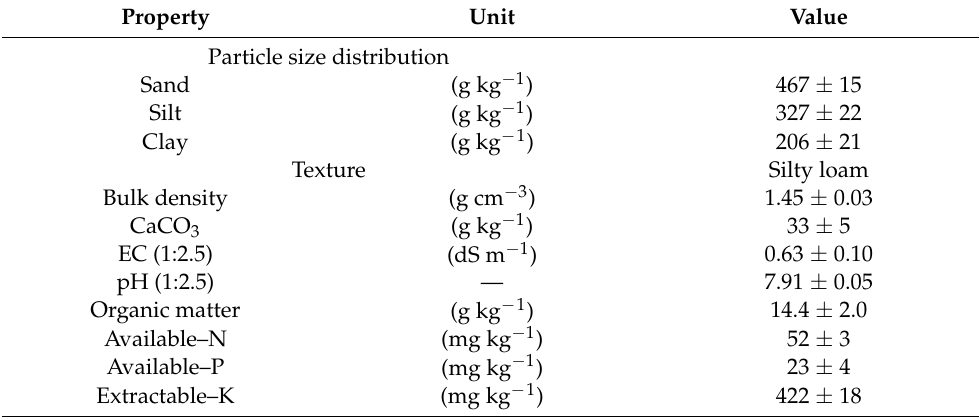
Table 1. Basic soil